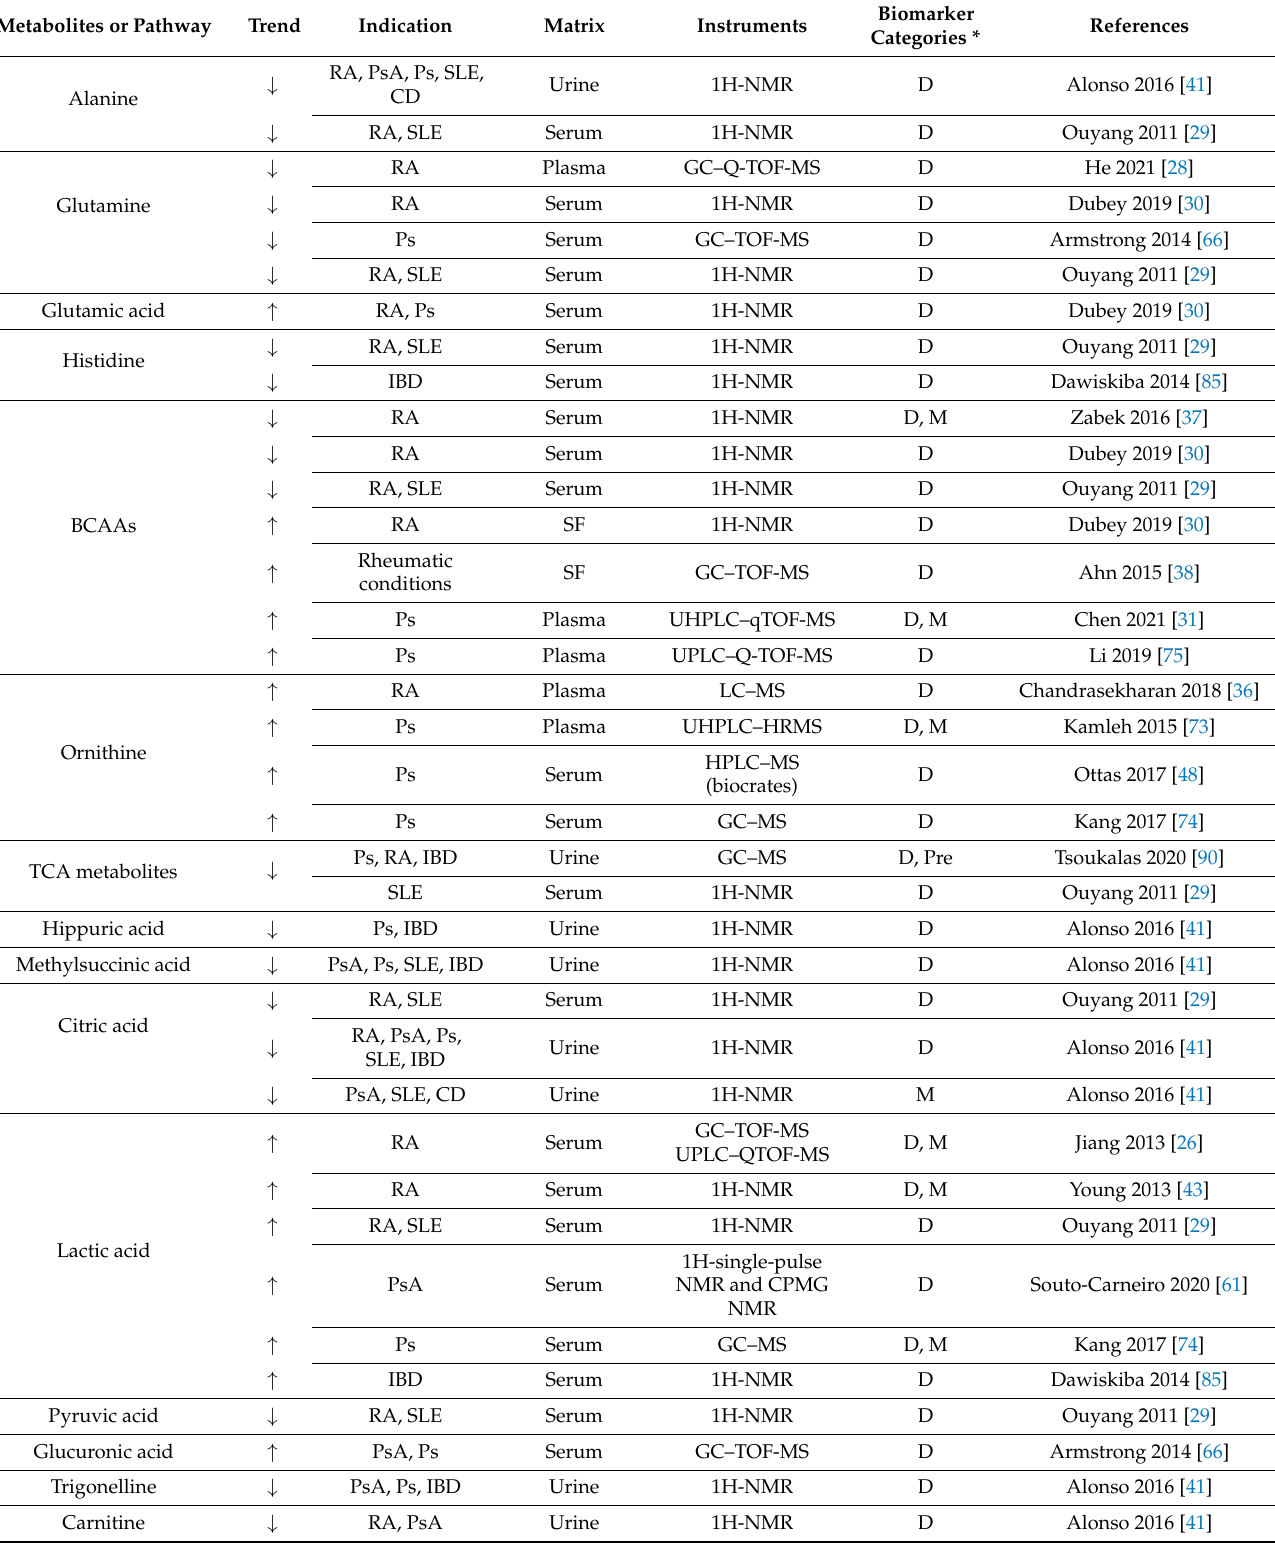
Table 5. Metabolites and pathways that show similar alterations in multiple